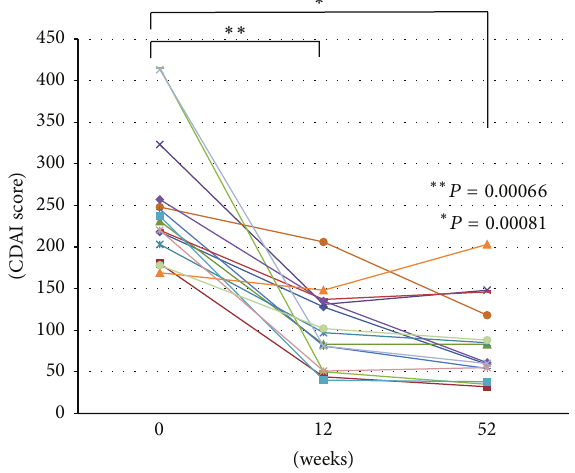
Figure 1: Crohn’s disease activity index (CDAI) scores before and at 12 and 52 weeks after the start of adalimumab (ADA) therapy.